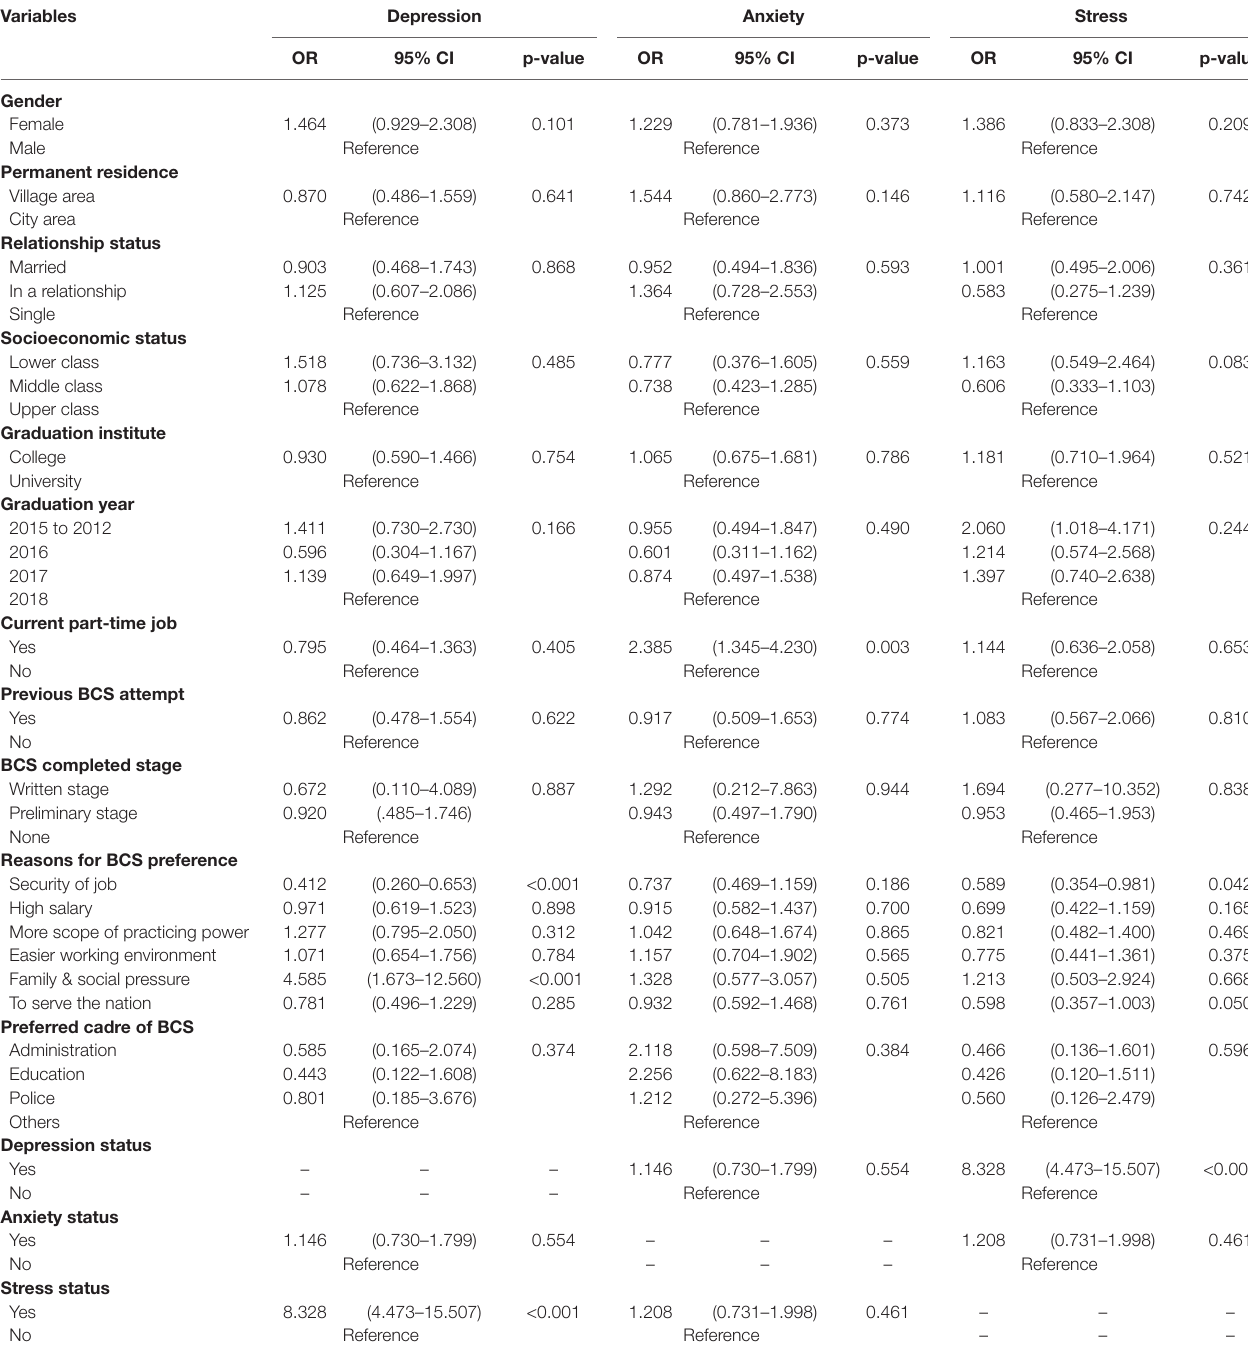
TABLE 2 | Binary regression analysis of the variables by depression, anxiety, and